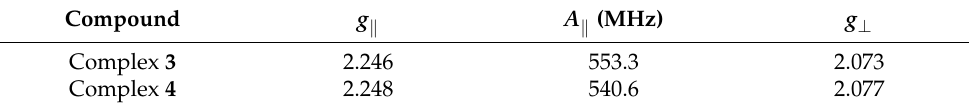
Figure 6. EPR spectroscopy at 77K. ( A ) Complex 3 in solid state ( B ) Complex 3 in DMSO ( C ) Complex 4 in solid state ( D ) Complex 4 in DMSO, In black: experimental spectra; in red: simulated spectra. Table 2. EPR simulation parameters for Complex 3 and Complex 4 in DMSO.